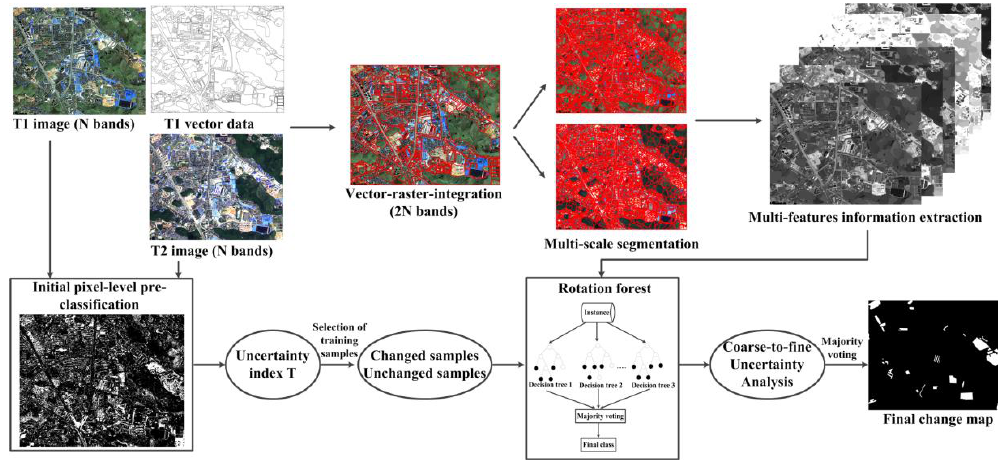
Figure 2. Flowchart of the proposed approach.